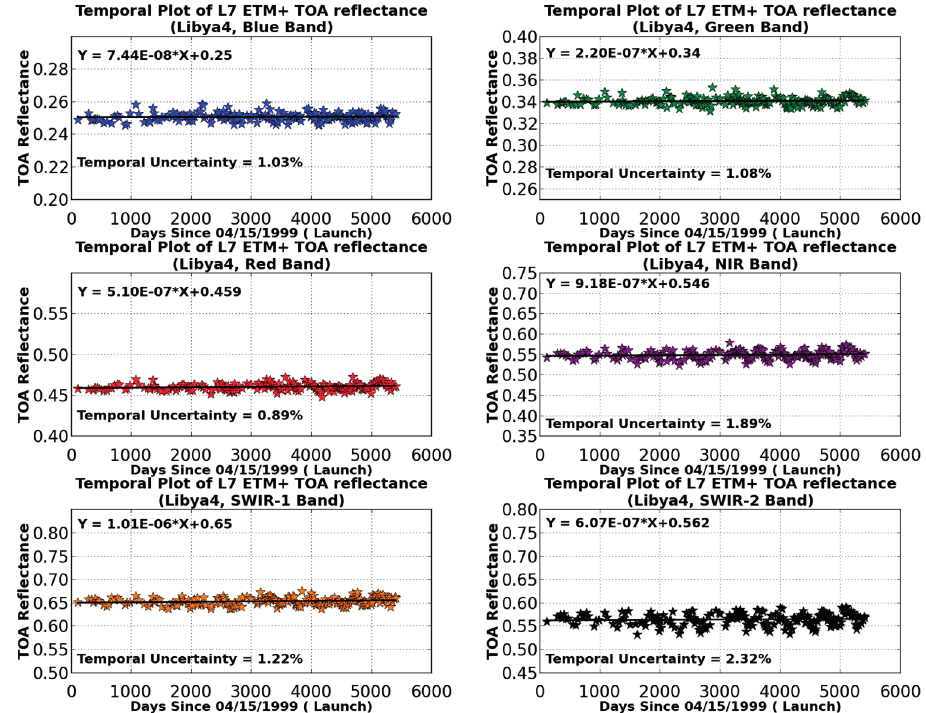
Figure 8. Temporal trend of L8 OLI over Libya 4